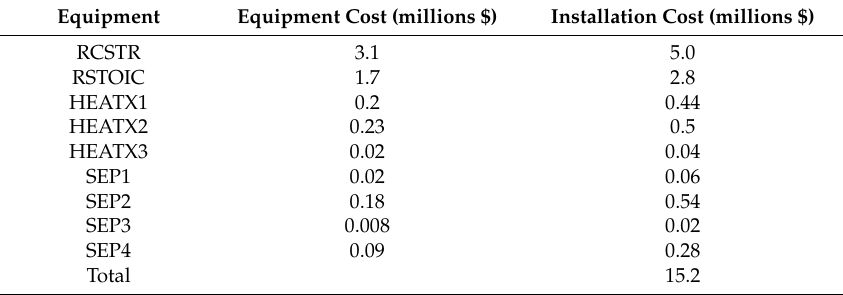
Table 4. Equipment costs and installation